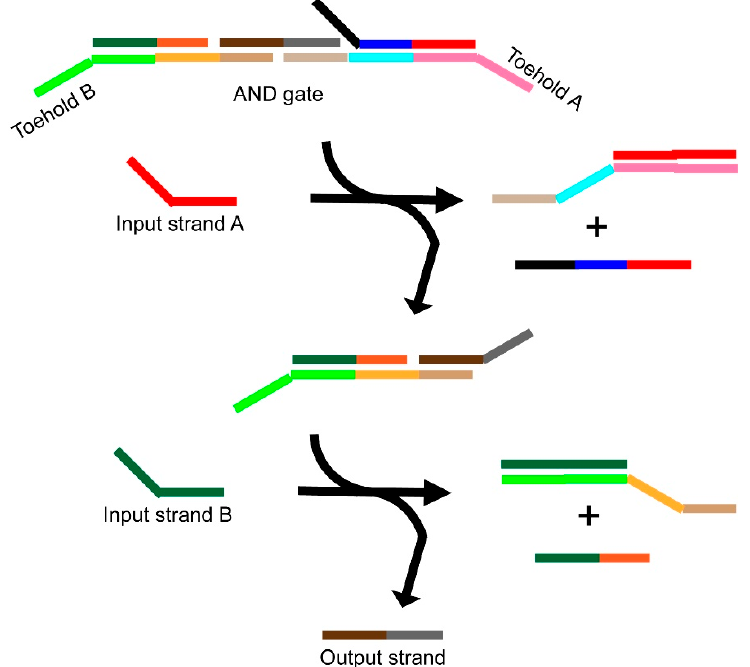
Figure 6. Schematic of a toehold-mediated strand displacement AND gate. Input strands A and B displace the complementary strands from the AND gate on either side of the output strand. The output strand is released only when both input strands hybridize with the gate.